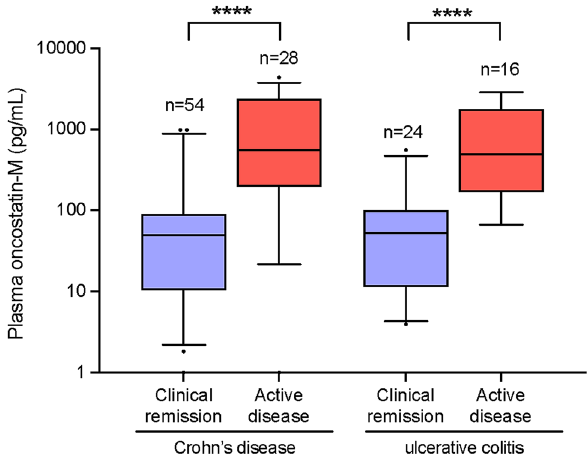
Figure 2. Mean plasma OSM concentrations in participants with Crohn’s disease and ulcerative colitis stratified by the presence or absence of clinical remission on a TNFA at 1-year are represented by box and whisker plot. Median values (thick horizontal line), 25th and 75th percentile values (box outline), 5–95% confidence intervals (whiskers); *p <